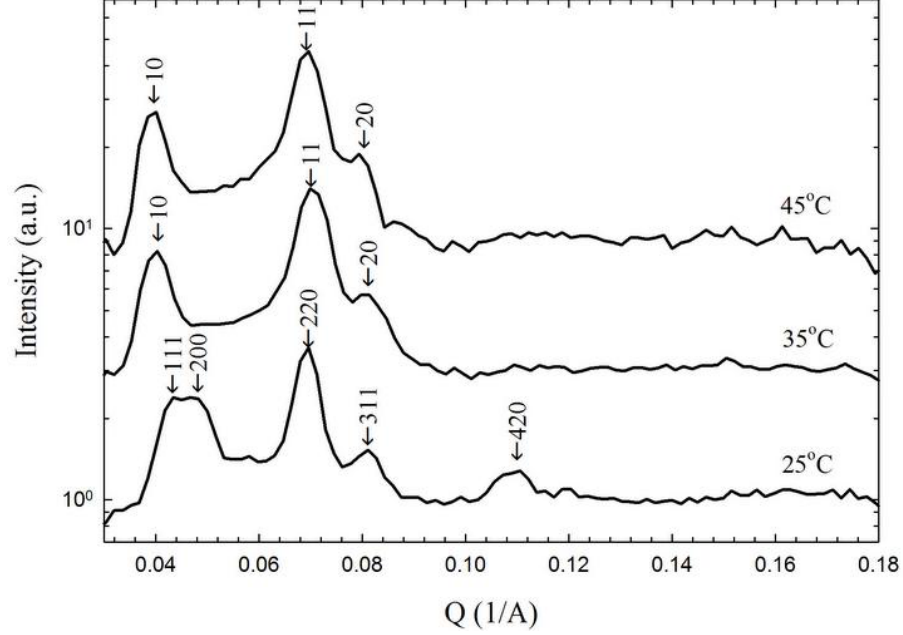
Figure 5. SAXS intensity versus scattering angle for 35 wt% block copolymer at three different temperatures. Peaks are indexed for a hexagonally-packed cylinder phase (35 °C and 45 °C) and a cubic phase (25 °C). Intensity is on an arbitrary scale and each curve is shifted by a factor of three for